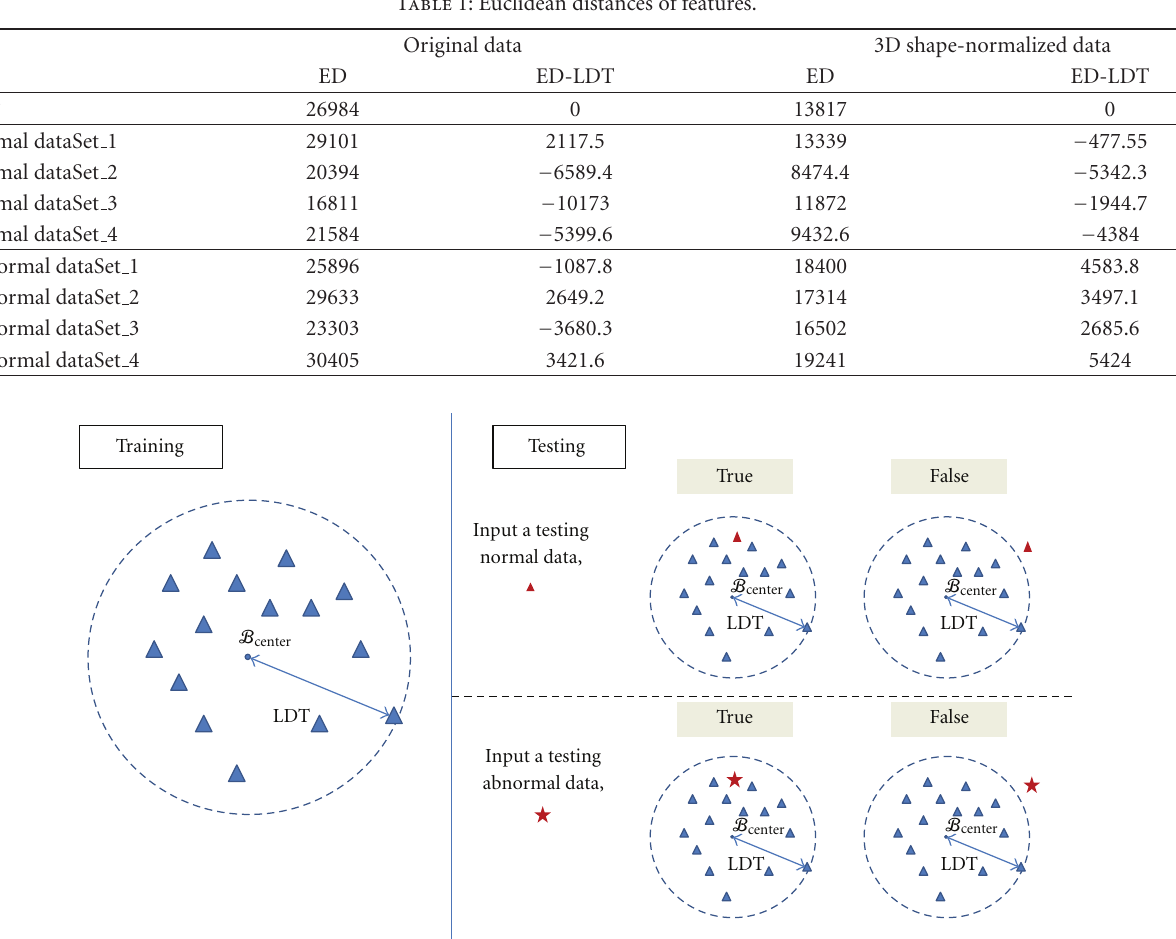
Figure 9: The rule for judging a test sample as normal or abnormal (2D case as